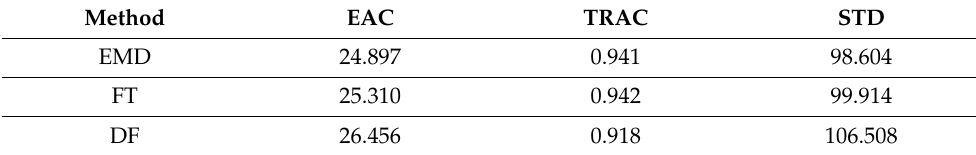
Table 1. Indexes of three methods.